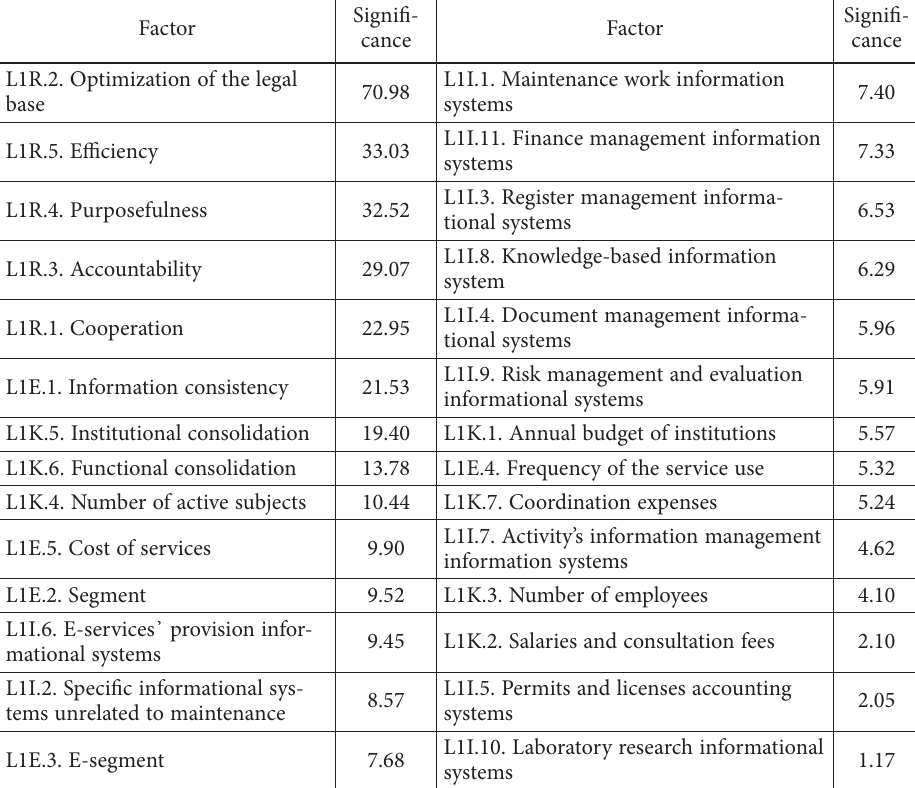
Table 6. The results of the significance of the factors that influence the efficiency of the consolidation of the activities of regulatory institutions while implementing e-government solutions (the results of the expert evaluation by regulatory institutions) (created by the authors) Signifi- Signifi- Factor Factor cance